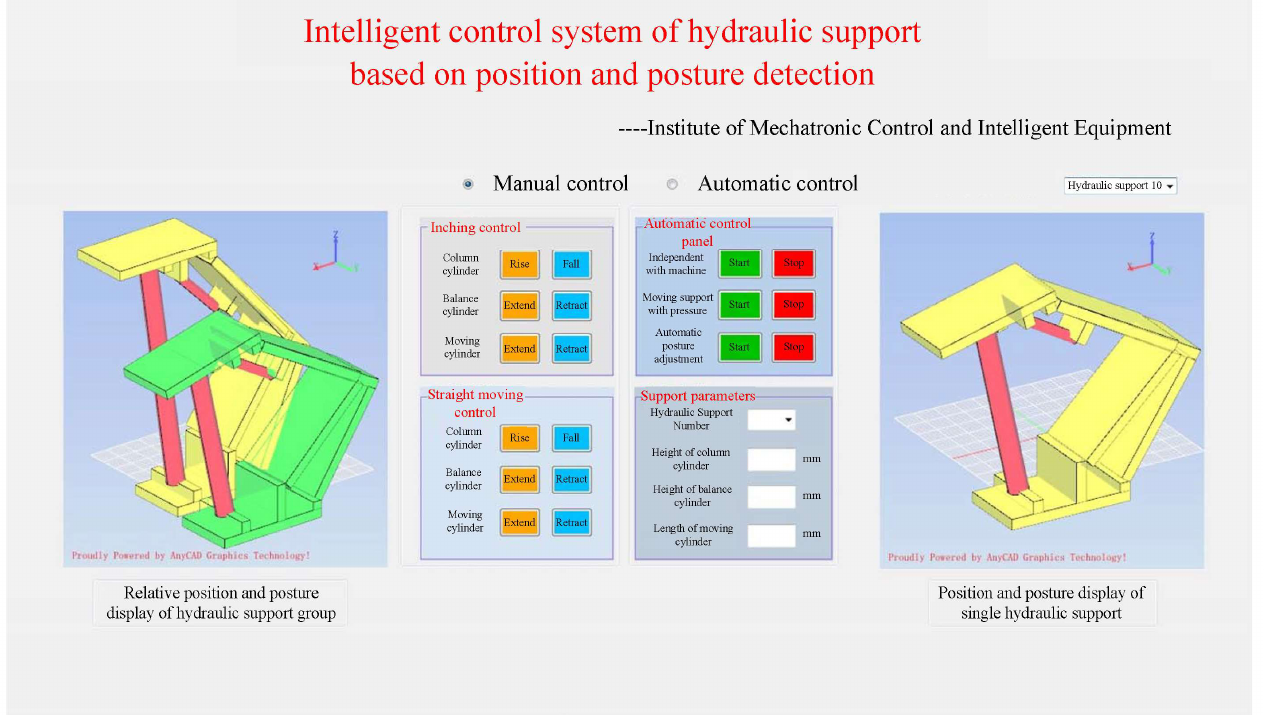
Figure 27. Autonomous following experiment of hydraulic support. ( a ) shows pushing scraper conveyor. ( b ) shows column telescopic lowering hydraulic support. ( c ) shows drag hydraulic support of scraper conveyor. ( d ) shows adjust the position and posture of the hydraulic support and complete automatic machine following.